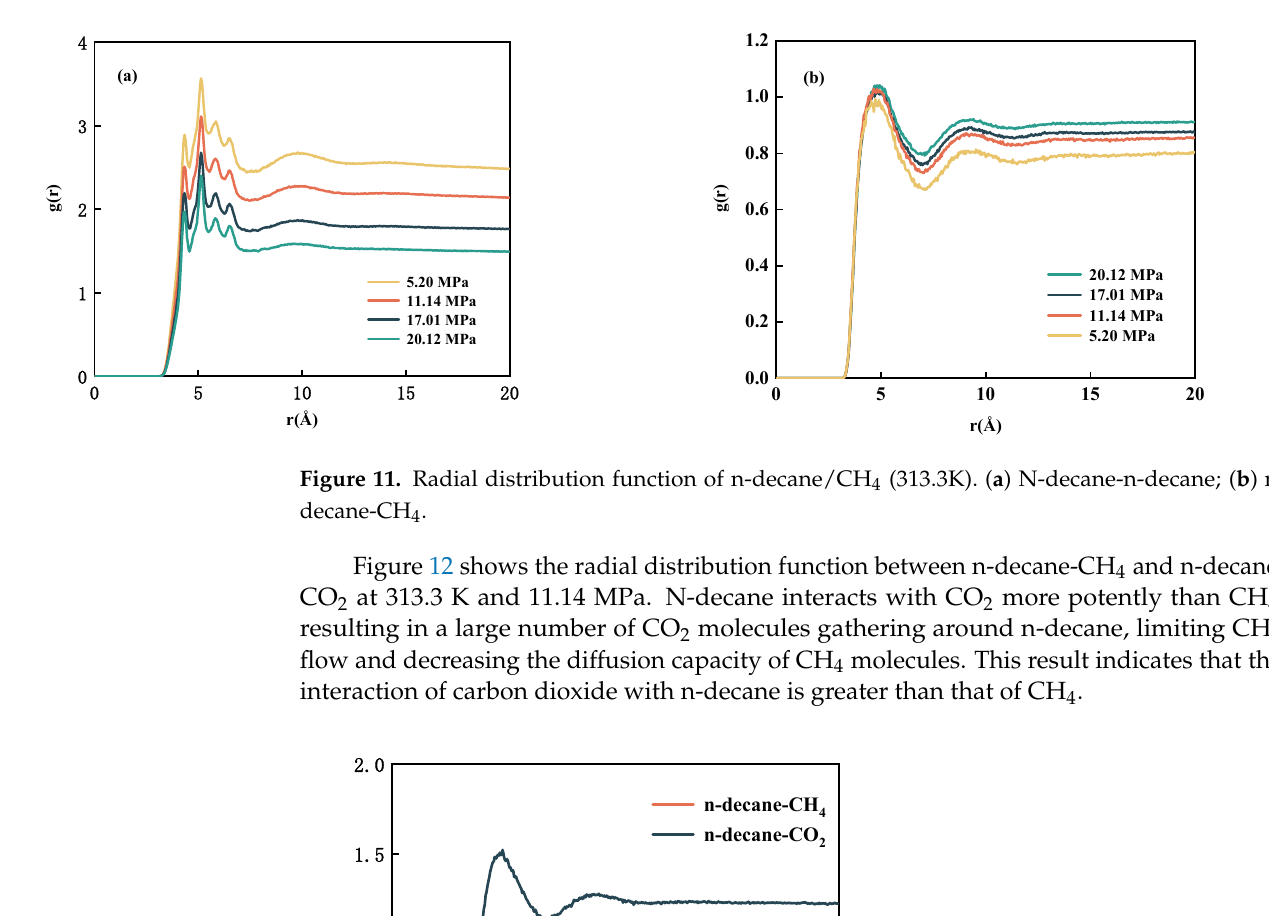
Figure 13. Radial distribution function of different component systems at 313.3 K, 5.2 MPa. ( a ) CH 4 - n-hexane, CH 4 -n-decane, CH 4 -n-nonadecane; ( b ) n-decane-n-hexane, n-decane-n-nonadecane. 4. Conclusions This study calculated the IFT between injected gas and crude oil using an MD simu- lation. The calculated IFT of the binary system of CH 4 + n-decane was in good agreement with the experimental data. The results indicate that MD simulation has good feasibility and accuracy in predicting IFT and is an alternative to experimental methods. The effects of pressure, temperature, gas composition, and crude oil composition on IFT are investi- gated, and the results show that: 1.